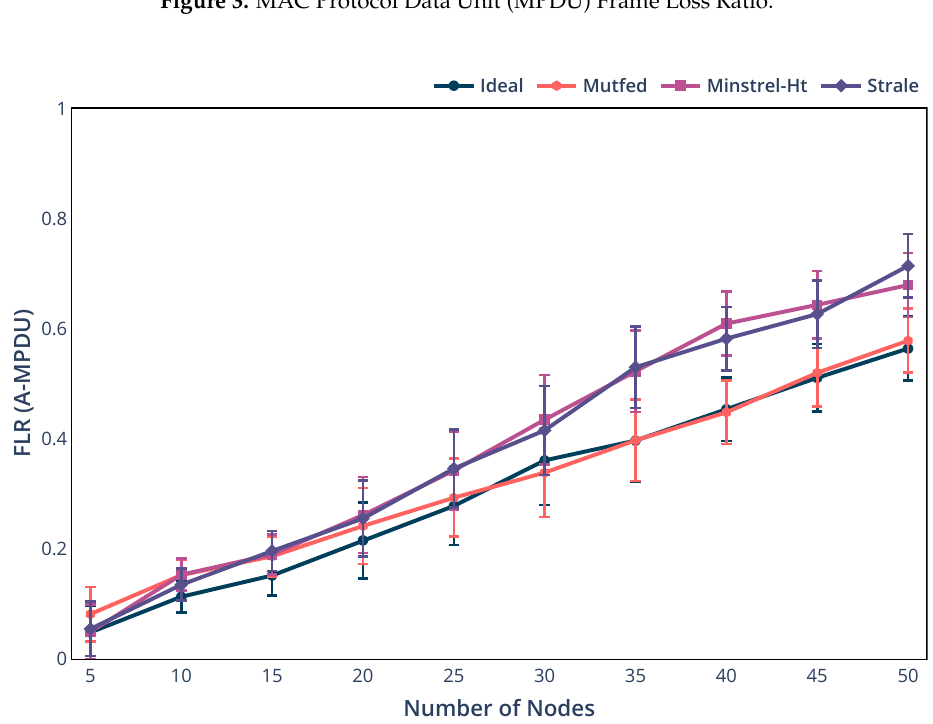
Figure 4. A-MPDU Frame Loss